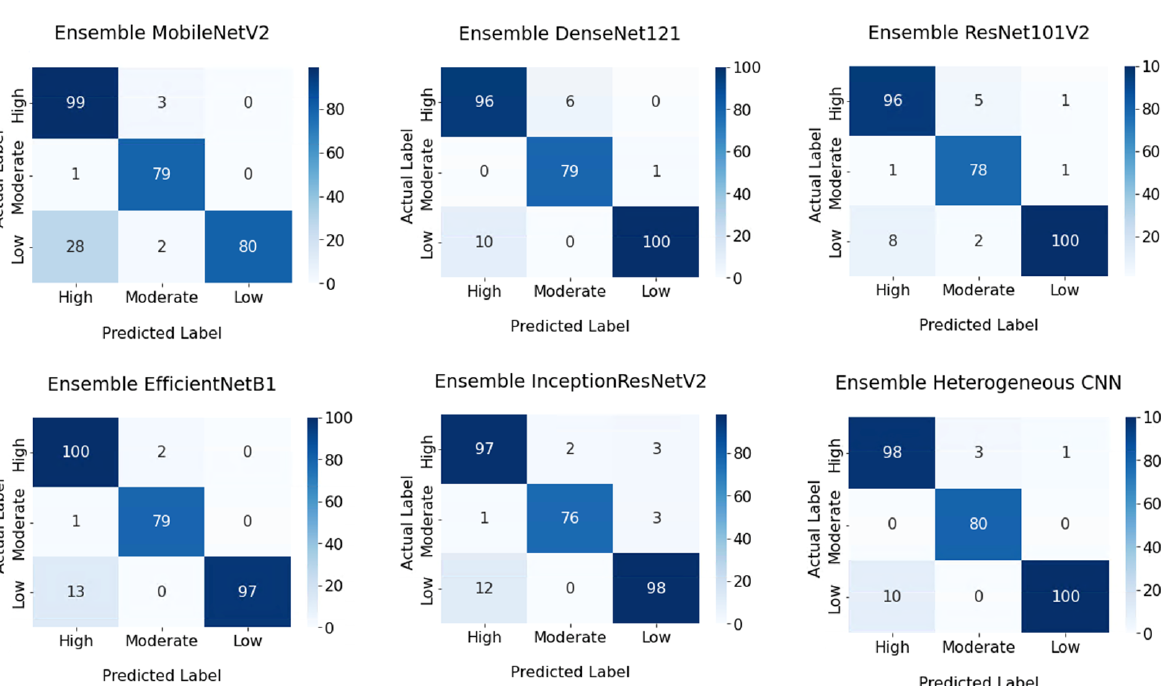
Figure 10. Confusion matrices of 3 classes.